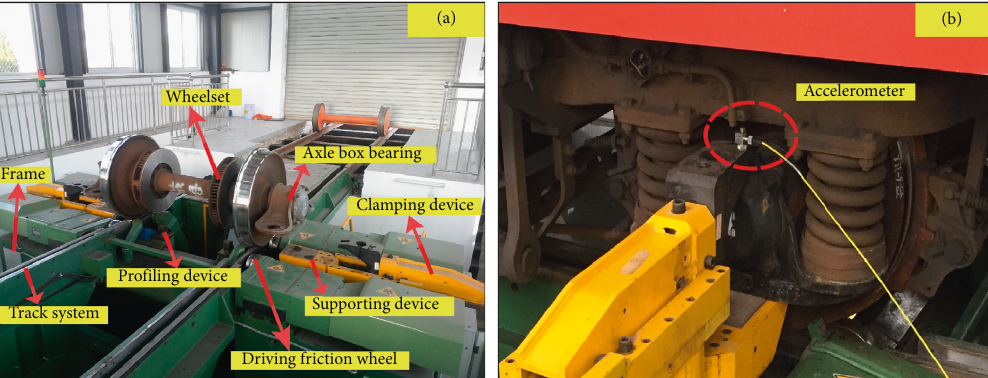
Figure 7: Experimental setup. (a) UGL-type underfloor wheelset lathe; (b) the installation location of the acceleration sensor. Table 1: Geometrical parameters of the